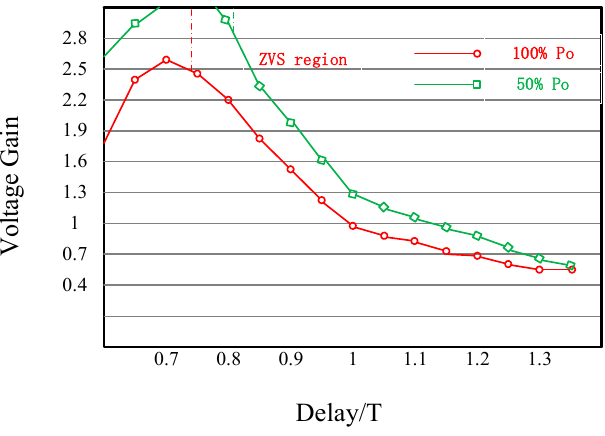
Figure 10. Relation between the voltage gain and drive delay.